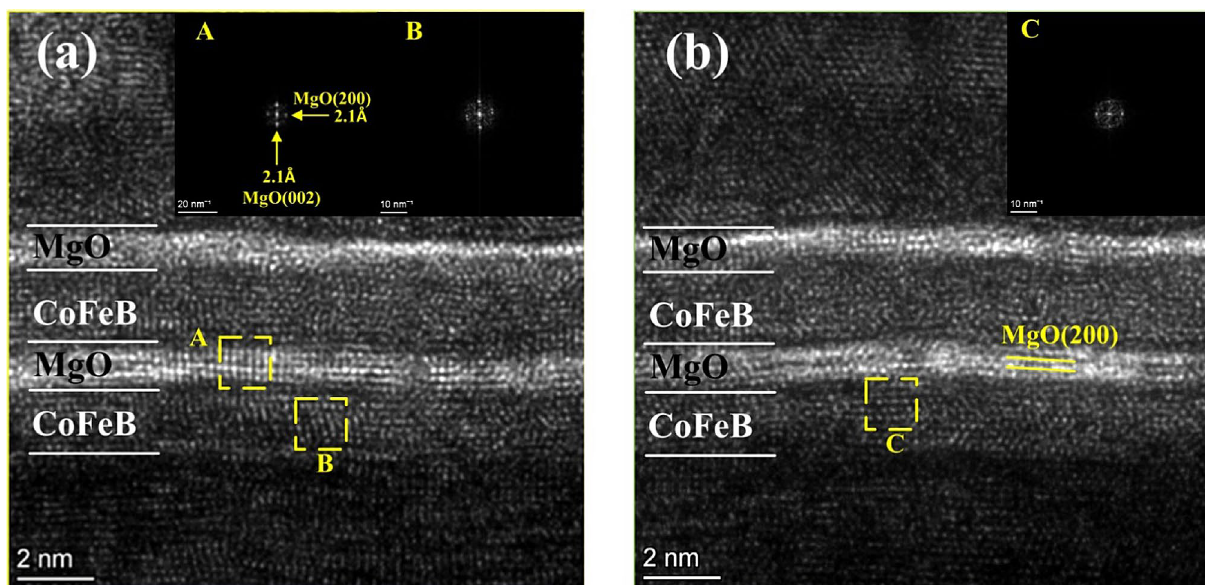
Figure 8. HRTEM image of MTJ devices ( a ) without radiation and ( b ) with 10 Mrad(Si)